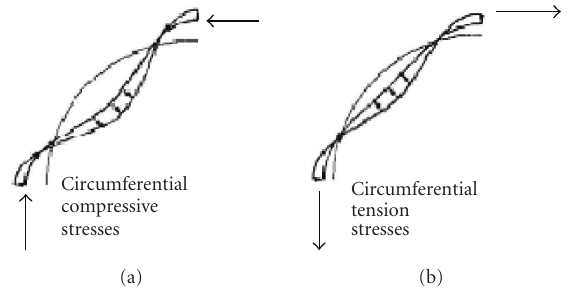
Figure 11: E ff ect of circumferential stresses.